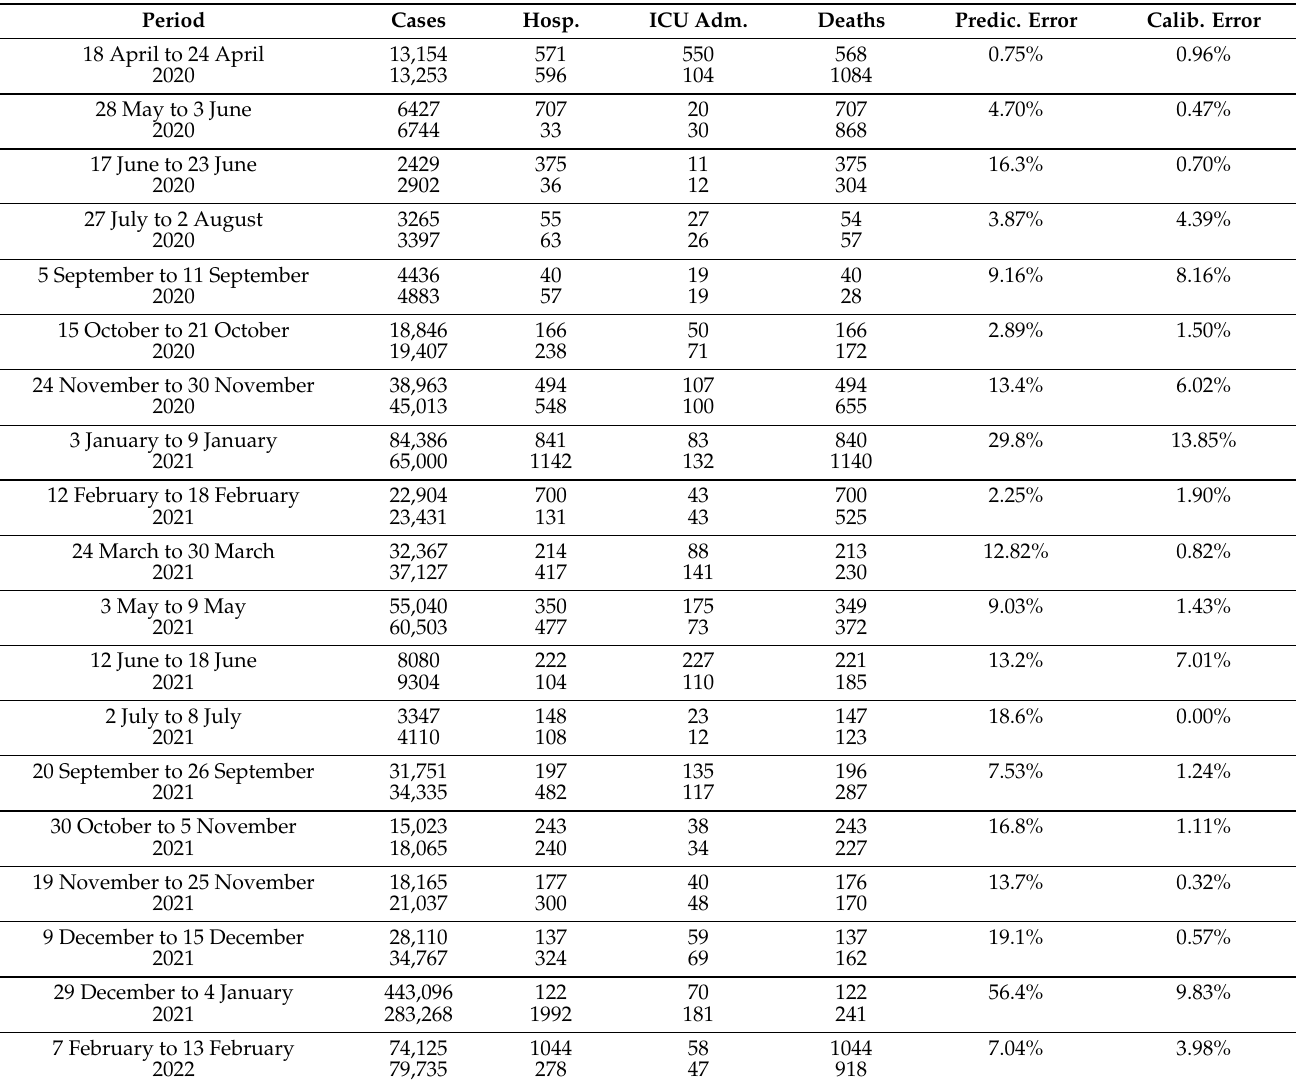
Table 1. Out-of-sample model predictions (top rows) and observed (bottom rows) accumulated numbers of COVID-19 cases, hospitalizations, ICU admissions, and deaths in Canada. Predic. Error and Calib. Error stands for the out-of-sample prediction and calibration errors,